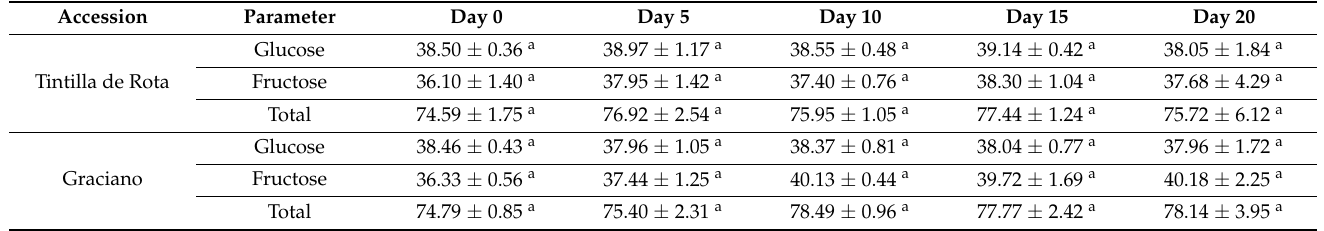
Table 1. Analytical results for sugars (glucose and fructose, in mg/g dry weight) during ripening period (days after ver á